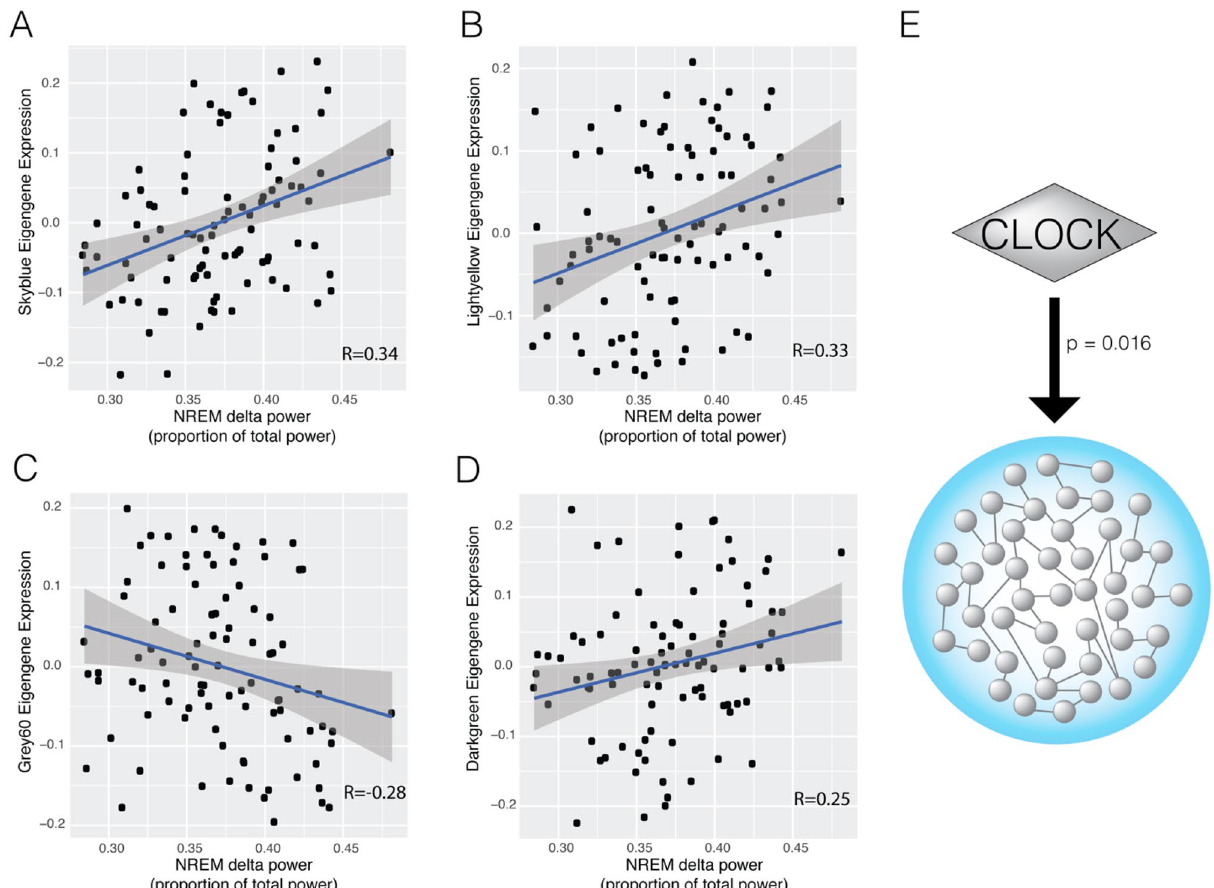
Figure 1. NREM delta power correlates with module eigengene expression of skyblue ( A ), lightyellow ( B ), grey60 ( C ), and darkgreen ( D ) modules. Correlation coefficients for each module-trait relationship is denoted in its respective panel. CLOCK knockdown directly modulates the expression of the skyblue module, with Fisher’s p-value reported in the figure ( E ). Summary statistics for panels ( A – D ) were originally represented in Supplementary Table 3 in PMID: